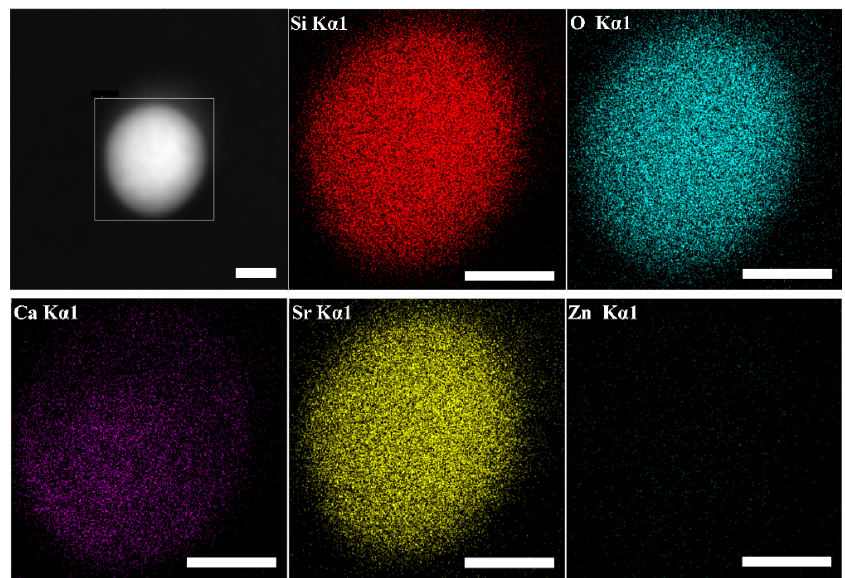
Figure 2. Distribution of 1.0Zn-BAGNPs’ elements using AZtec imaging software on TEM (a JEOL 2100 Plus microscope, conducted at Imperial College London). Scale bars = 50 nm.